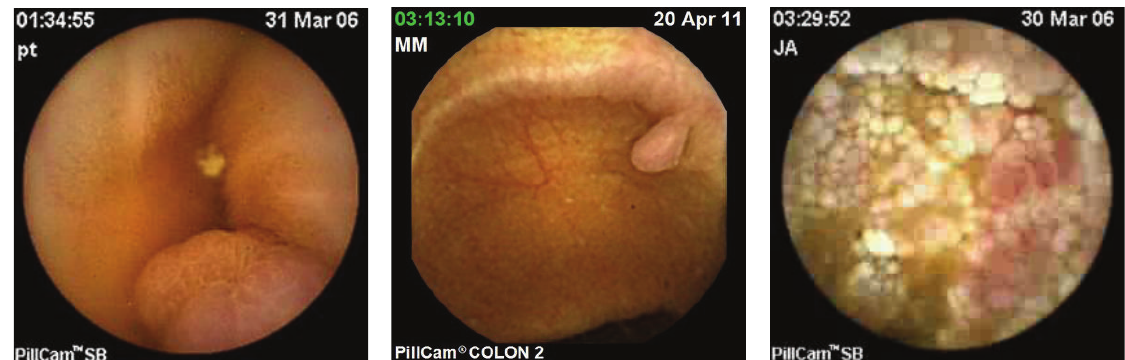
Figure 2: Three images extracted from three different videos made with a Pillcam © WCE (taken from the freely available database “Gastro Vid´eo Web” (http://dr.dm.gastro.free.fr/)).